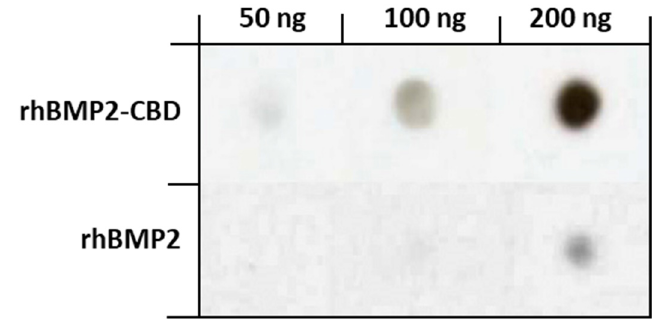
Figure 5. Collagen binding of a rhBMP2-CBD chimeric growth factor. Collagen type I sponges were loaded with different amounts of rhBMP-2 or rhBMP2-CBD, let dry and washed with PBS for 7 days. Molecules that remained bound to the sponges were detected using an anti-BMP-2 antibody. Modified from [107].